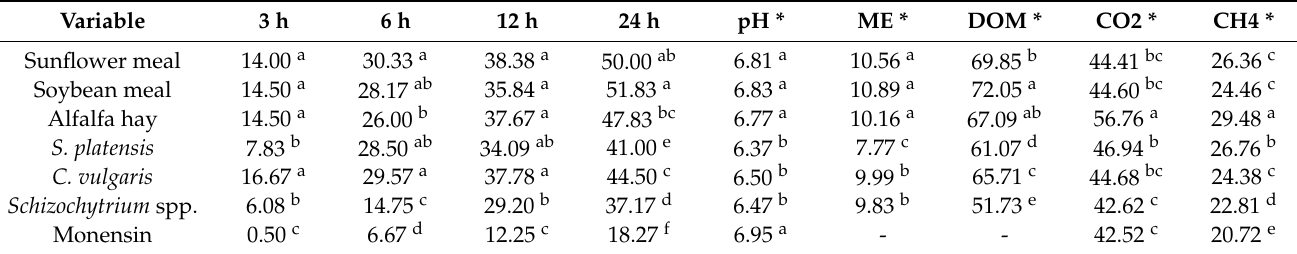
Table 3. In vitro total gas volume (mL), rumen pH, estimated metabolizable energy (ME; MJ/kg), digestible organic matter (DOM; g/kg DM), CO 2 (mL) and CH 4 (mL)